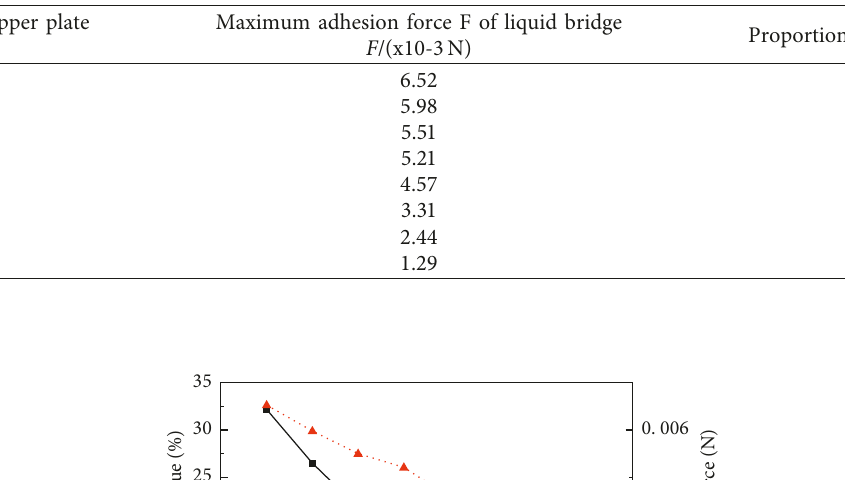
Table 5: Simulation values under different contact angles.